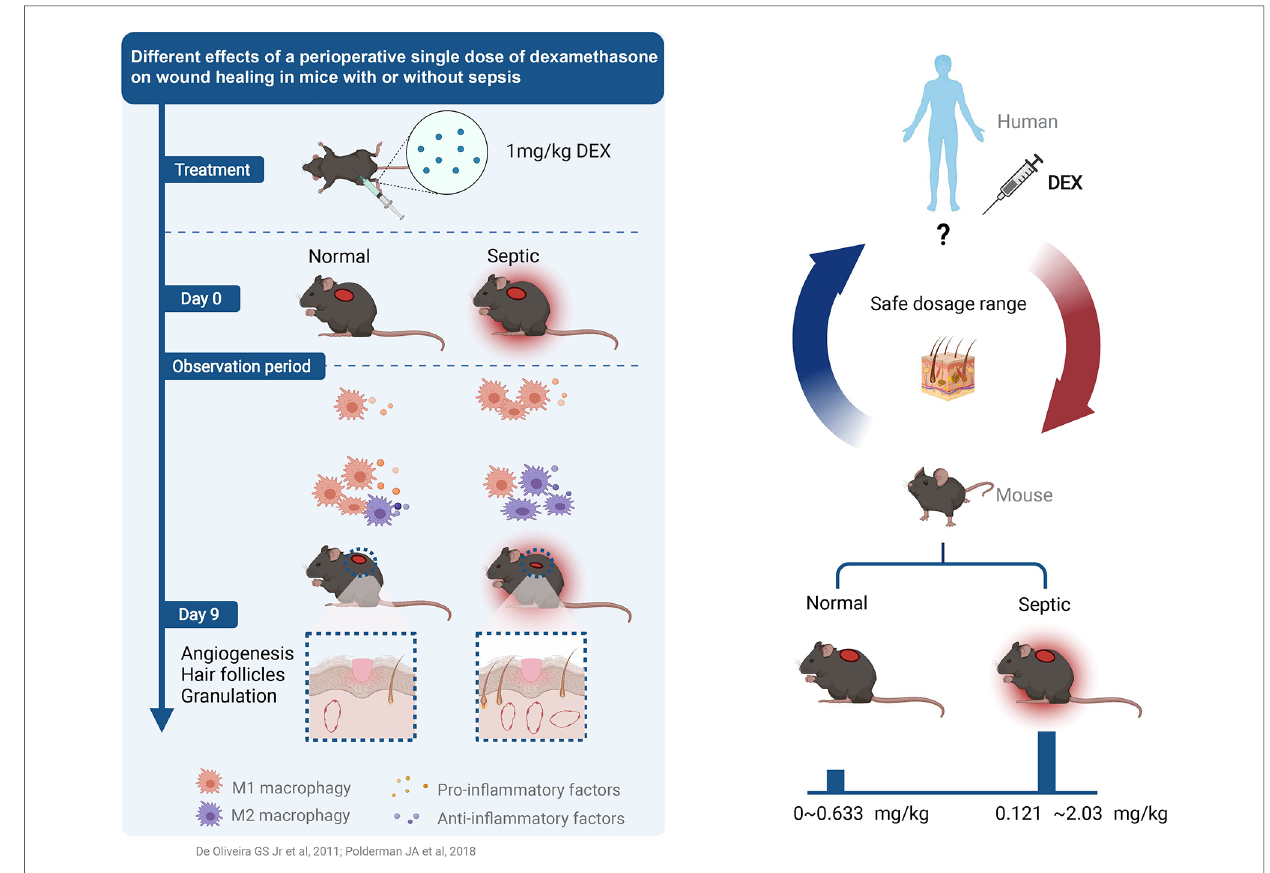
FIGURE 7 Different effects of a perioperative single dose of dexamethasone on wound healing in mice with or without sepsis (50,